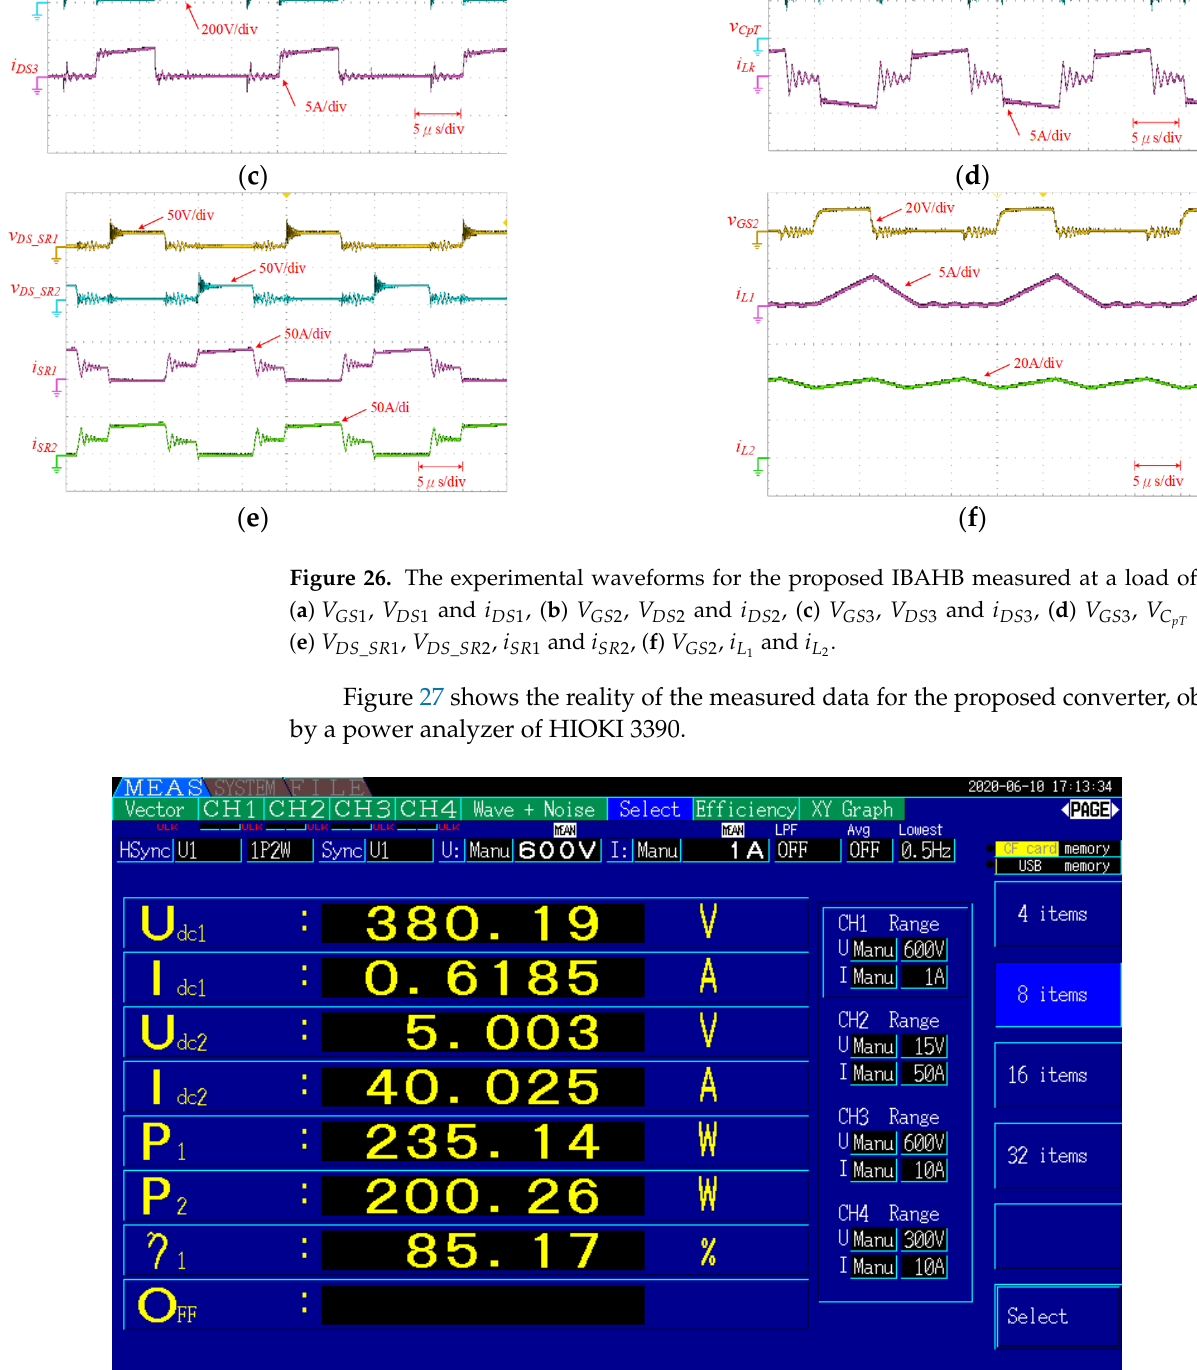
Figure 27. The reality of measured data of the proposed converter. The maximum efficiency and full-load efficiency of the proposed topology are 86.65% and 85.17%, respectively. The experimental results confirm that the proposed topology